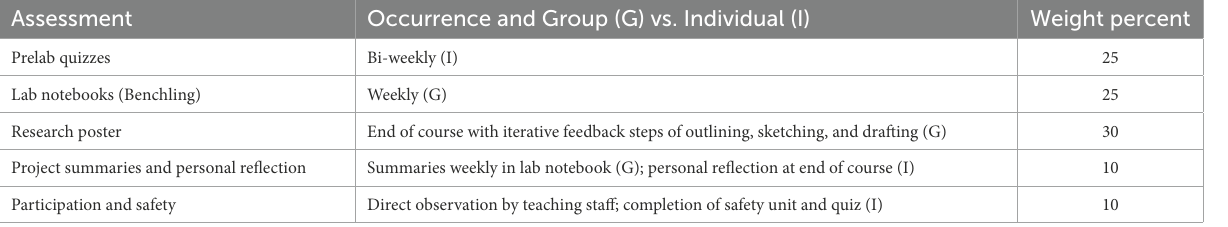
TABLE 2 Student assessments and relative